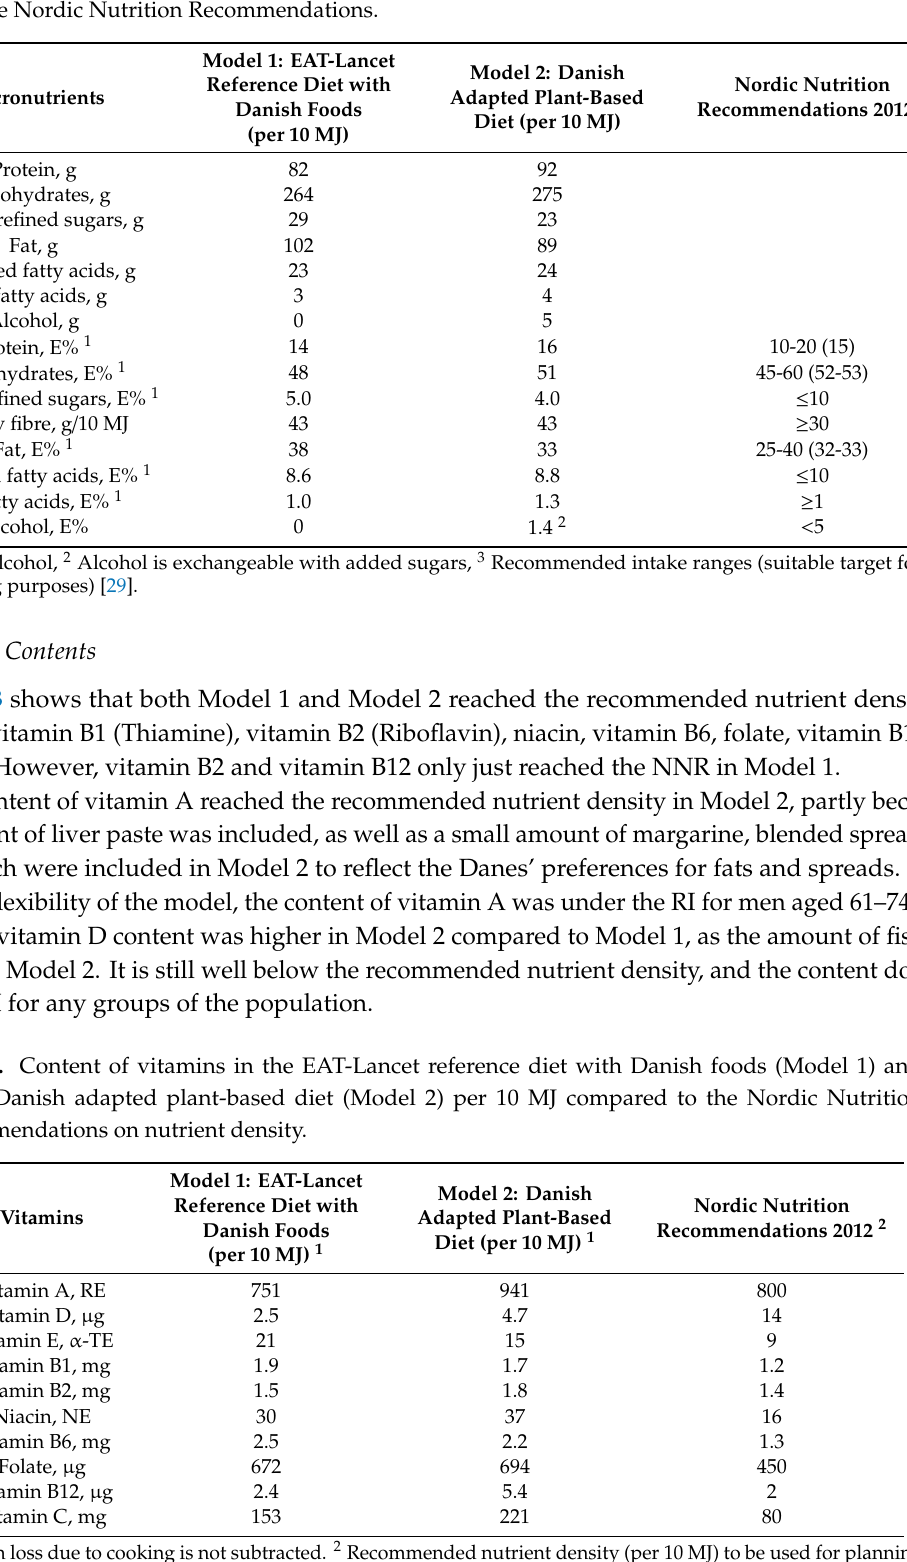
Table 2. Content of macronutrients in the EAT-Lancet reference diet with Danish foods (Model 1) and in the Danish adapted plant-based diet (Model 2) per 10 MJ, compared to recommended intake ranges from the Nordic Nutrition Recommendations.